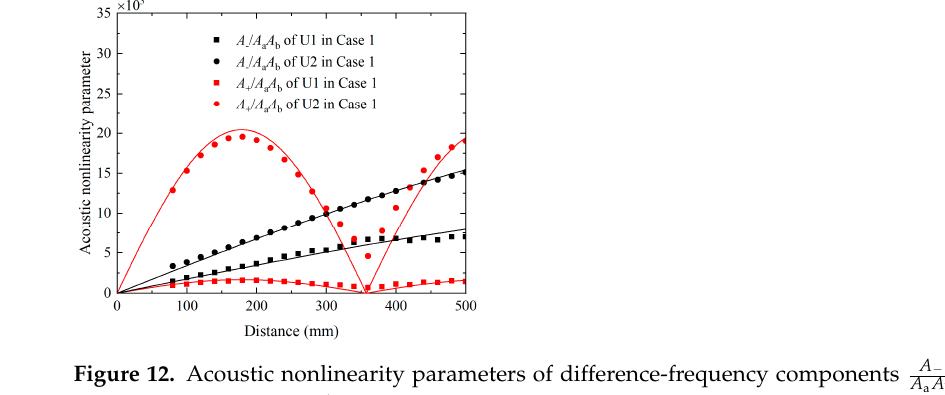
and sum- A a A b